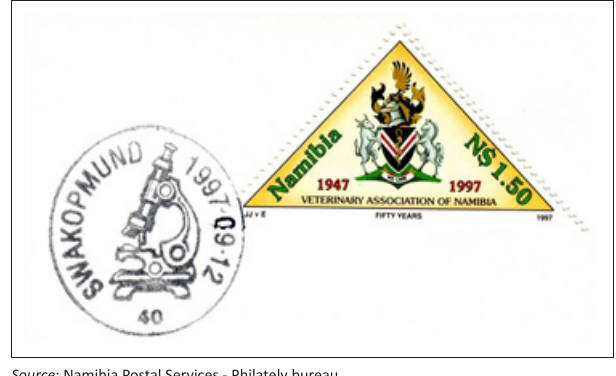
FIGURE 7: Special stamp issued by the Namibia Postal Service in 1997 to commemorate the 50th anniversary of the Veterinary Association of